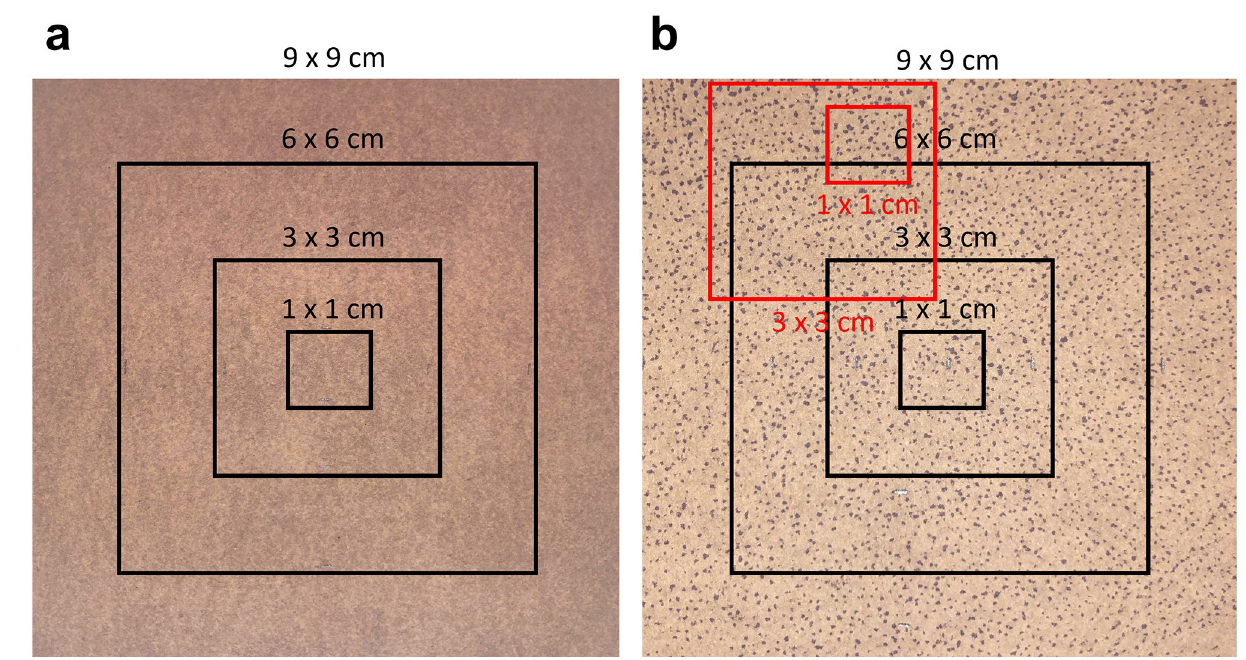
Fig 1. ( a ) Cotton paper divided into pre-determined areas and ( b ) Iodine impregnated paper displaying sweat gland activation within the pre-determined and optimal (red) areas.